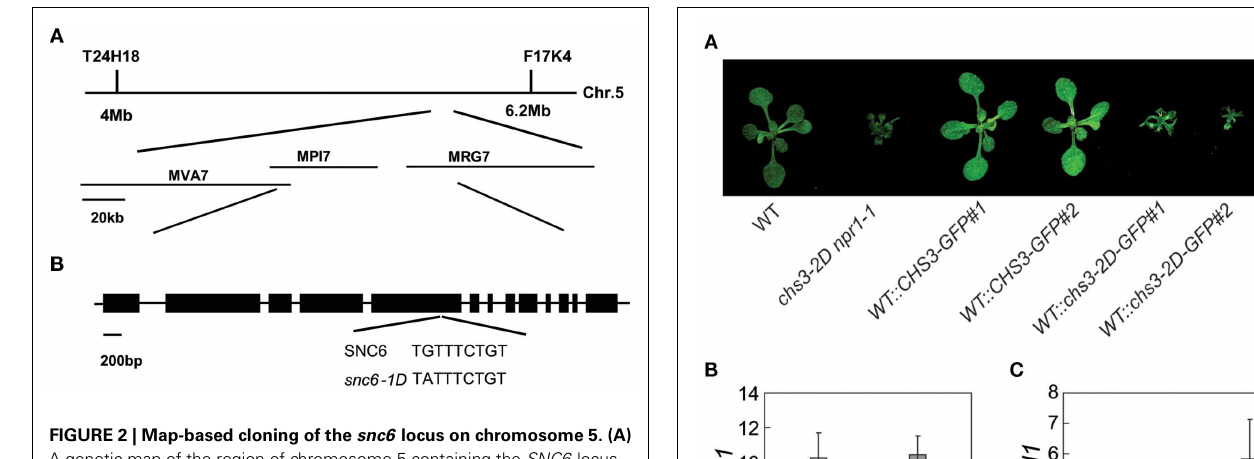
FIGURE 2 | Map-based cloning of the snc6 locus on chromosome 5. (A) A genetic map of the region of chromosome 5 containing the SNC6 locus, with markers used for mapping indicated. (B) Gene structure of SNC6 ( At5g17890 , previously named CHS3 ) and the position of the molecular lesion in snc6-1D / chs3-2D . Boxes and lines represent exons and introns, respectively.